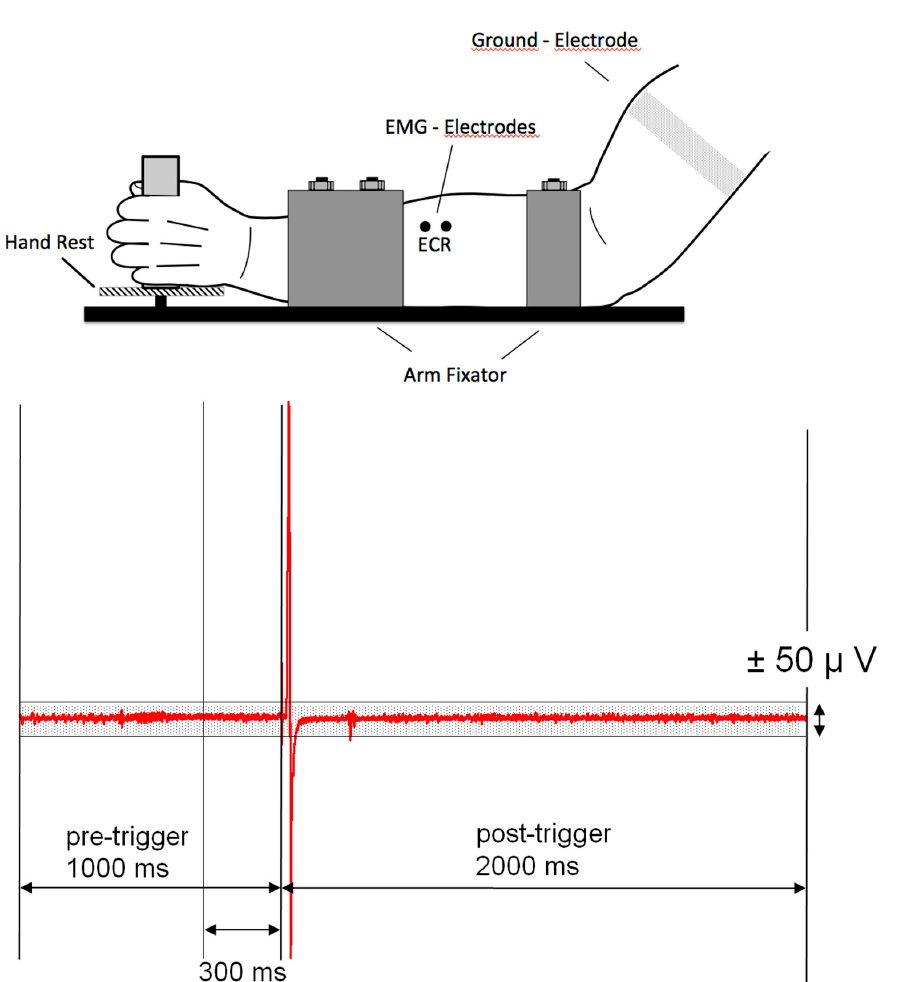
Figure 5. The MEP used for the evaluation of the different digital Butterworth filter-parameter were recorded in a completely relaxed state supported with a hand rest and a lower arm fixator. The recorded time window was of 3000 ms duration. The MEP raw data (lower part) shows a single measurement of a typical data set with 1000 ms pre-trigger. The window for the elimination of background activity was 300 ms before trigger with an amplitude of ±50 µV.